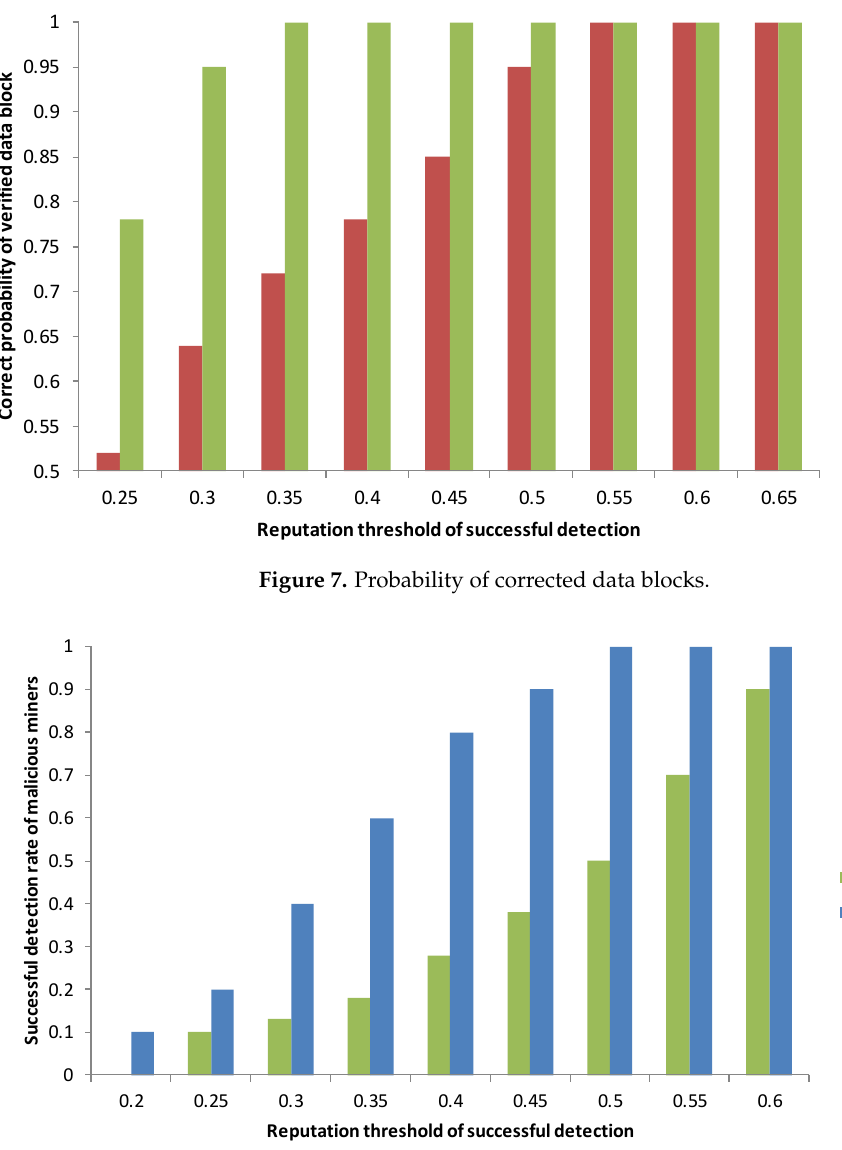
Figure 8. Detection rate of malicious miners.